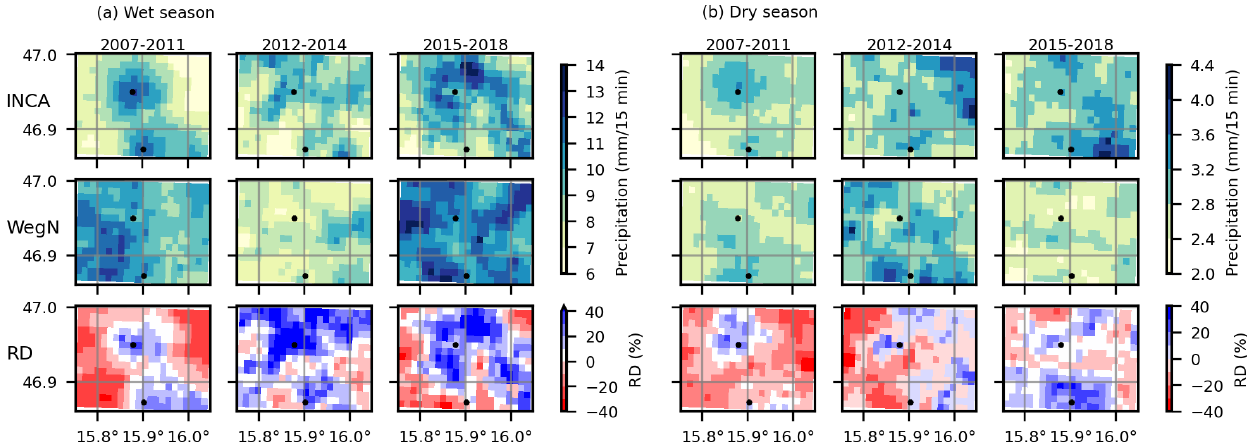
Figure 8. Spatial patterns and relative difference of the mean of all time steps exceeding the 99th quantile for INCA and WegenerNet for (a) wet and (b) dry seasons in the first (left), second (middle), and third (right) periods.